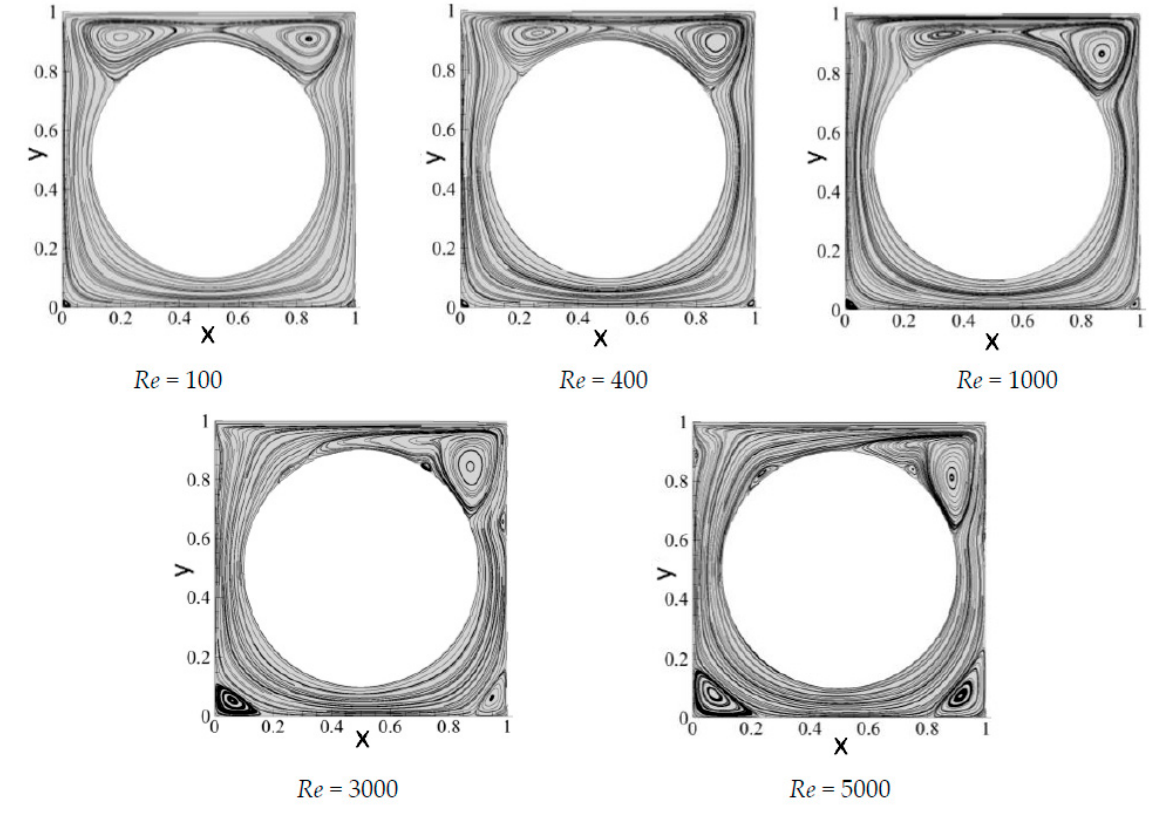
Figure 8. Streamlines of the lid-driven square cavity flow with an internal circular obstacle at different Reynolds numbers at 2 /5 r = .